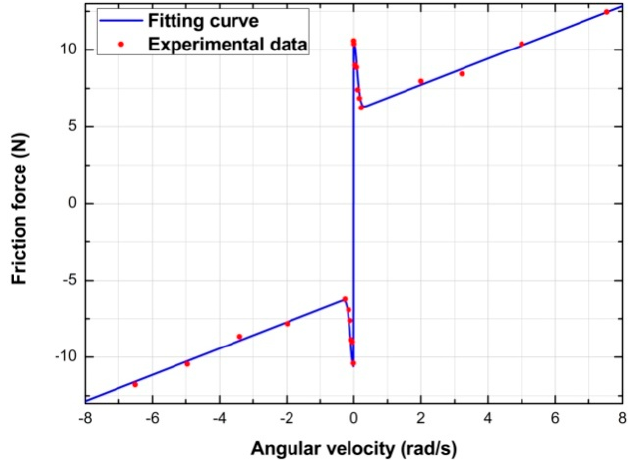
Figure 3. Force–velocity curve of the friction model.